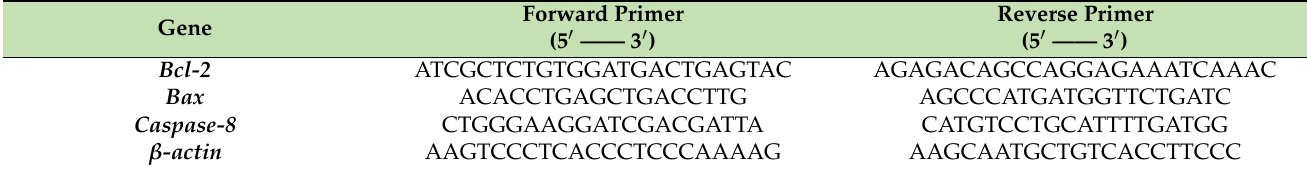
Table 3. Primers used in the synthesis of